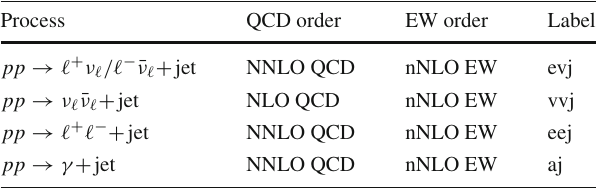
Table 2 List of processes, highest available QCD and EW order, and process labels used in data files (see Table 3). Predictions for pp → ν (cid:3) ¯ ν (cid:3) + jet are available only at NLO QCD, but corresponding NNLO QCD corrections and uncertainties can be taken from pp → (cid:3) + (cid:3) − +